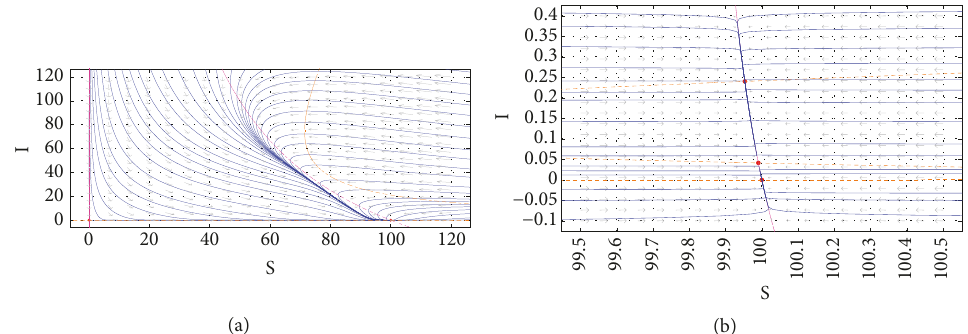
Figure 2: Phase portrait of the system when a backward bifurcation occurs at 𝑅 0 = 1 . In (a), the DFE is globally asymptotically stable and 𝑅 < 𝑅 ∗ . In (b), the DFE is unstable, there are two endemic equilibria, and 𝑅 ∗ < 𝑅 0